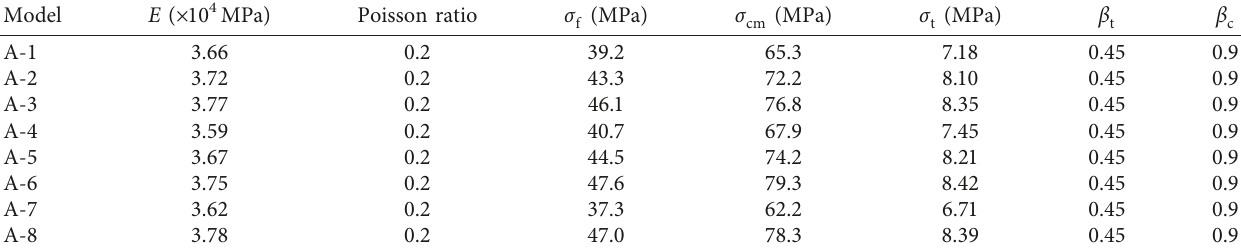
Table 10: The force parameter table of